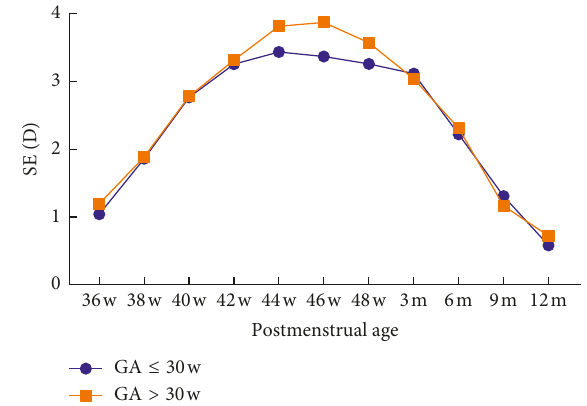
Figure 4: Correlation between SE and GA. SE, spherical equivalent; D, diopter; GA, gestational